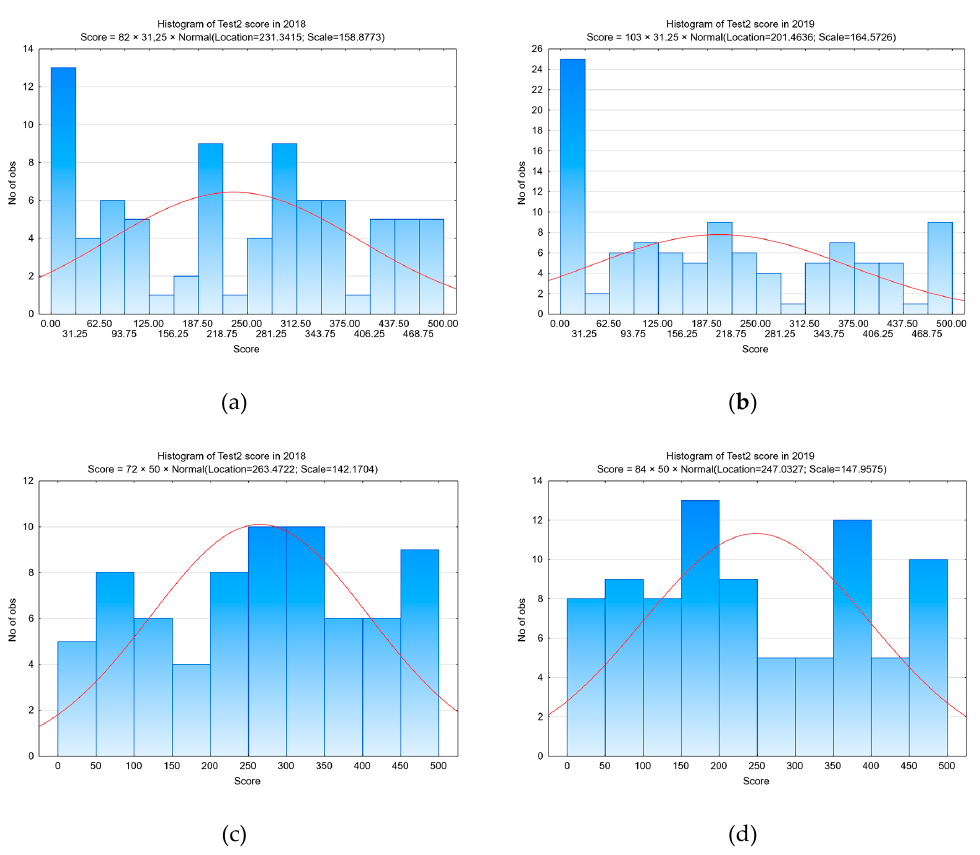
Figure 8. Histogram of test score distribution in monitored groups: ( a ) Test score in the group trained without microlearning in 2018; ( b ) Test score in the group taught with microlearning in 2019; ( c ) Test score in the group trained without microlearning in 2018 without students who failed during the semester; ( d ) Test score in the group trained with microlearning in 2019 without students who failed during the semester. The red curve represents the outline of the normal distribution of values.